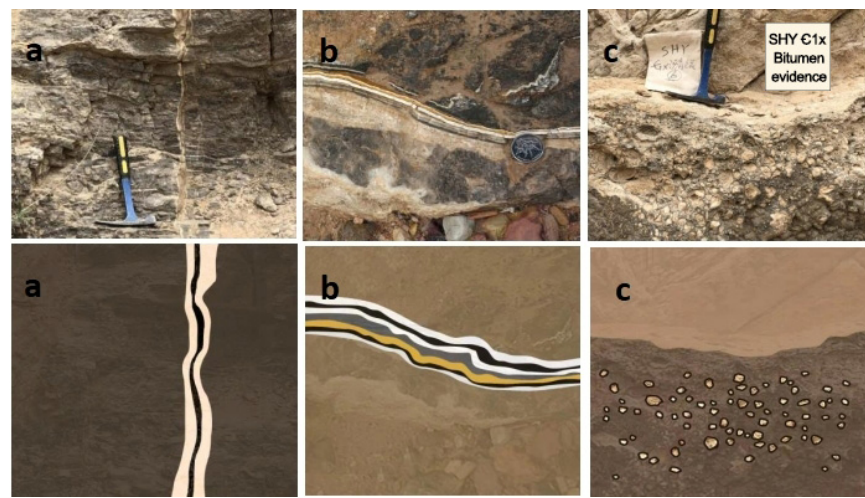
Figure 9. Different bitumen phenomena of Xiaoerblak Formation in Shihuiyao section: ( a ) single-stage bitumen vein at bottom; ( b ) multistage bitumen veins in the middle and upper parts; ( c ) bitumen-coated gravel in the upper part.